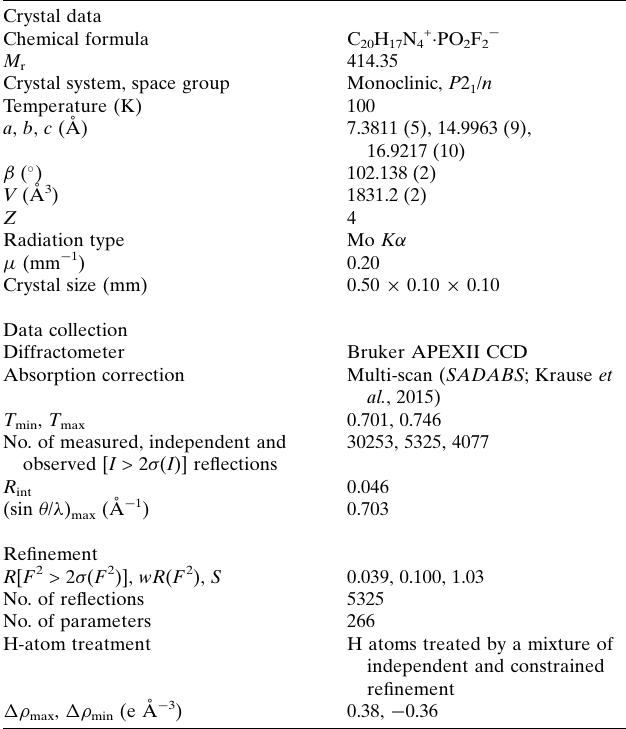
Table 4 Experimental details. Crystal data Chemical